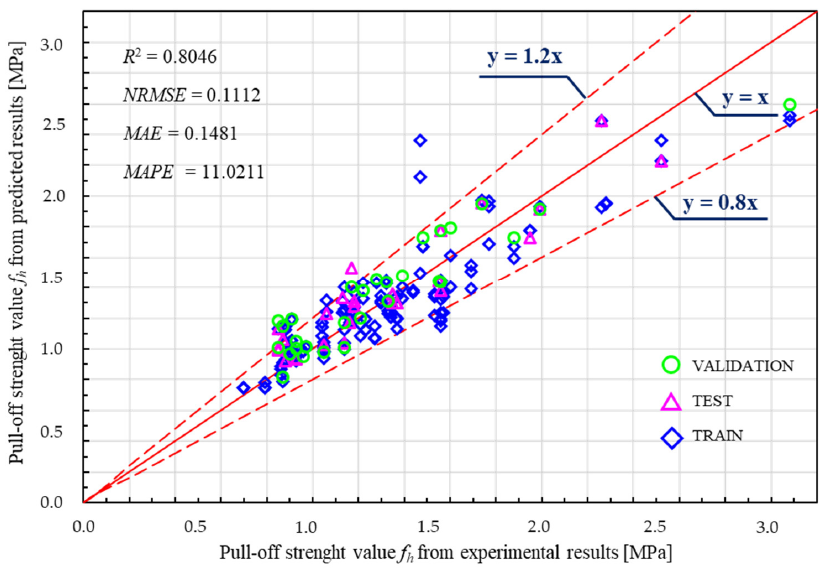
Figure 13. Relationship between the predicted value and the experimental value of the pull-off strength f h for ANN test, train, and validation process for the LM algorithm with two layers of hidden neurons.